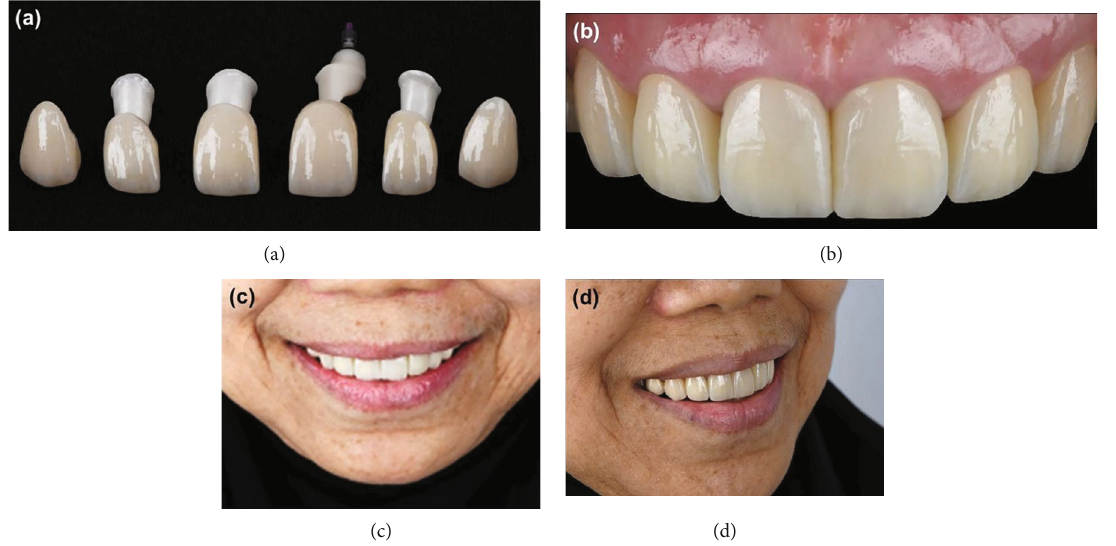
Figure 7: Final restorations. Zircona crowns (a), cemented in the patient (b), front view of the crowns in the patient (c), and side view of the crowns in the patient